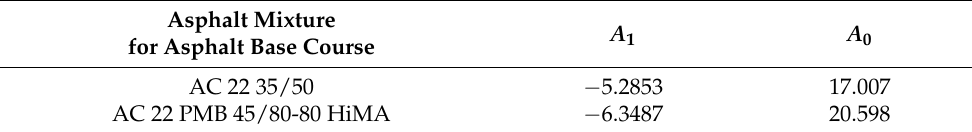
Table 5. Fatigue coefficients of the tested asphalt mixtures according to formula (10).